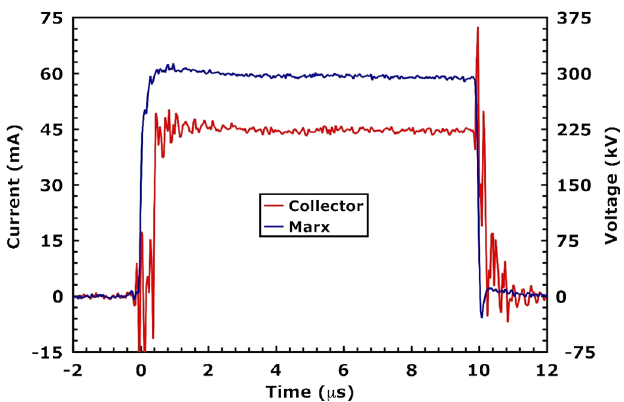
FIG. 2. (Color) Marx voltage waveform used to extract the beam through the diode (blue) and the measured beam current 28 cm downstream of the diode (red; z (cid:6) 40 cm ).